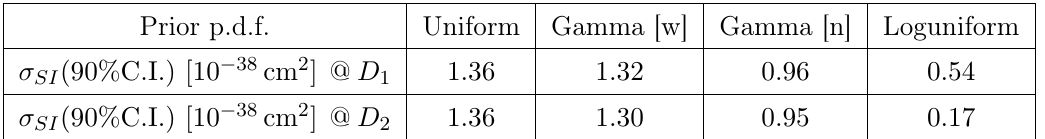
Table 1 . (cid:27) SI (90% C:I: ) for each of the prior choices. The [w] index states for “wider” and the [n] index stands for